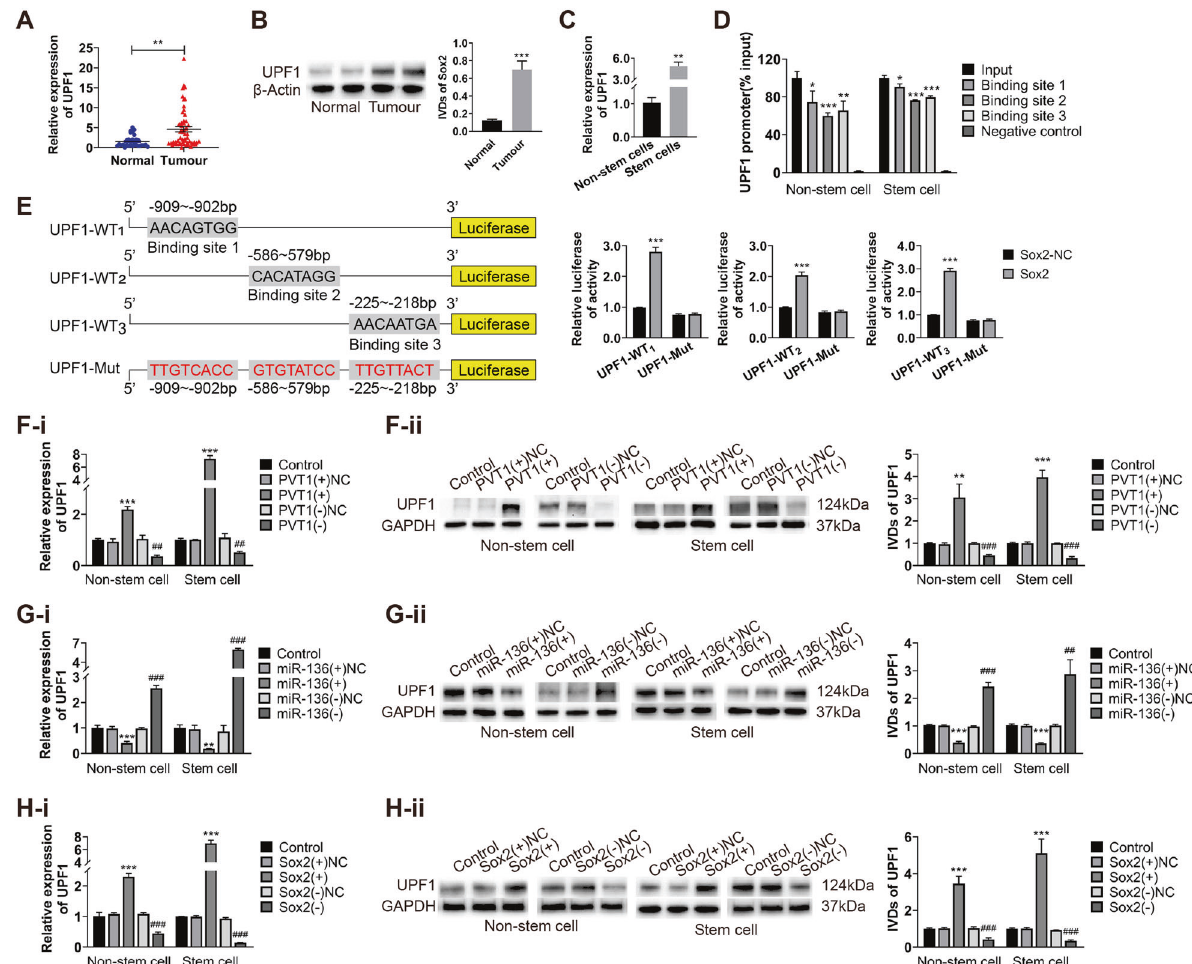
Fig. 6 UPF1 is the direct target of Sox2 to promote malignant behavior in ECCs and ECSCs. A , B UPF1 expression was evaluated in endometrial cancer tissues ( n = 55) and normal endometrial tissues ( n = 30) by qRT-PCR and western blot. C UPF1 expression was evaluated in endometrial cancer non-stem cells and stem cells by qRT-PCR. D The binding of Sox2 and UPF1 was detected by ChIP. E The targeted binding sites of Sox2 and UPF1 were validated by dual-luciferase reporter assays. Data are presented as the means ± SD ( n = 3, each group), * P < 0.05, ** P < 0.01, *** P < 0.0001 vs. control group. F Changes in the expression of UPF1 were detected by qRT-PCR and western blot after PVT1 was regulated. Data are presented as the means ± SD ( n = 3, each group), * P < 0.05, ** P < 0.01, *** P < 0.0001 vs. PVT1( + )NC group; # P <